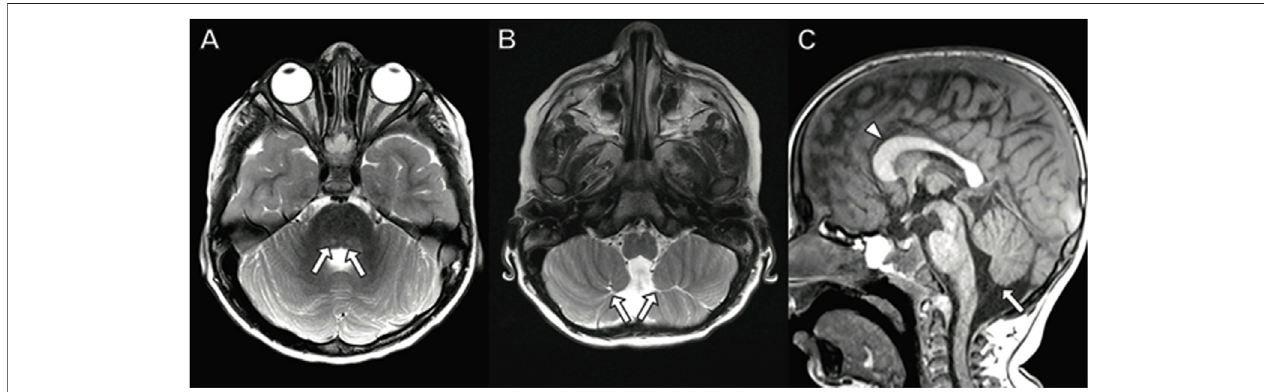
FIGURE2| Brain MRIina3-year-oldboywith PACS2 mutation. (A) AxialT2demonstrates hyperintensesignal inthecentral tegmentaltracts (arrows). (B) AxialT2 imageshowsdysplasticcerebellarfolia(arrows). (C) SagittalT1imagewithdysplastic,abnormallythickgenuofthecorpuscallosum(arrowhead)andvermianhypoplasia